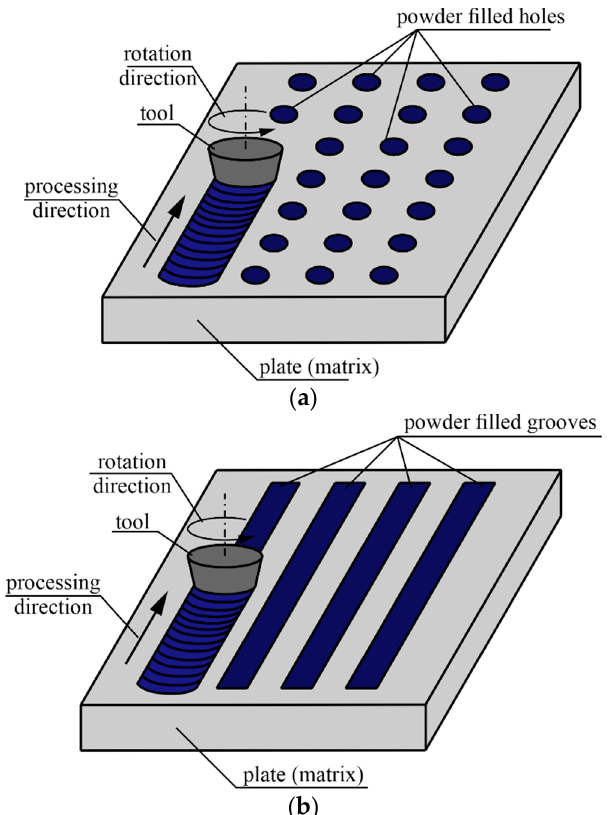
Figure 7. Schematic of the FSP process with the addition of reinforcements filled ( a ) into holes in the substrate and ( b ) into a groove.